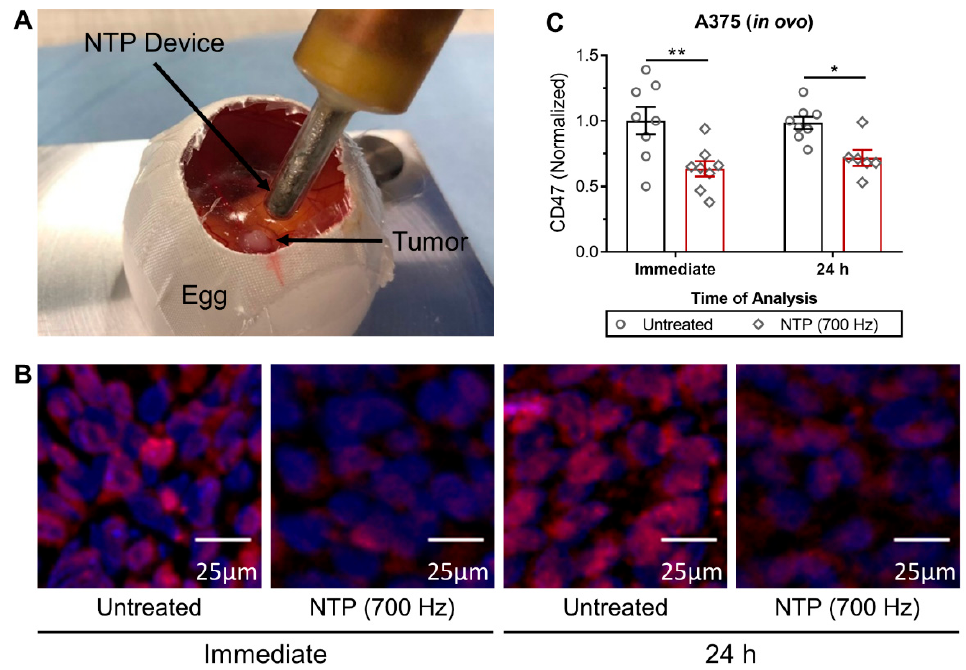
Figure 2. NTP treatment decreased CD47 expression of A375 melanoma tumors in an in ovo model. ( A ) Tumors were grown on the chorioallantoic membrane (CAM) of fertilized eggs and treated directly with NTP. Following treatment, tumors were resected immediately or 24 h post treatment, sectioned, and ( B ) stained for CD47 (red) and counterstained with DAPI (blue). All images were taken on the same day at 10× and batch processed for quantification to limit variations. ( C ) Quantification of CD47 was normalized to the untreated. Data here are represented as mean ± SEM and individual values are also shown (n = 6–8). Statistical significance of all treatment conditions was determined using the generalized linear mixed model with post hoc Dunnett’s test comparison to untreated (* p ≤ 0.05; ** p ≤ 0.01).